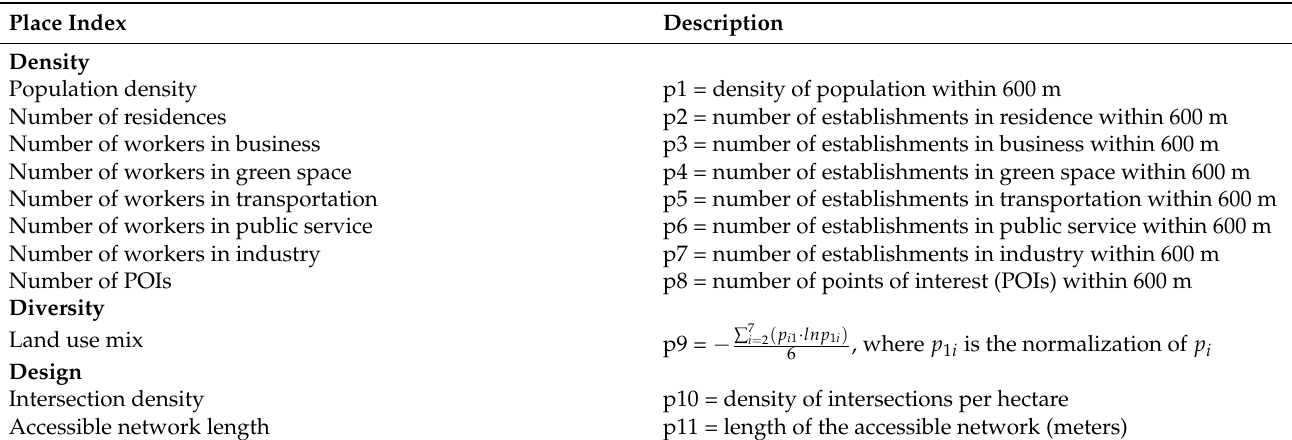
Table 2. Indicators of the node